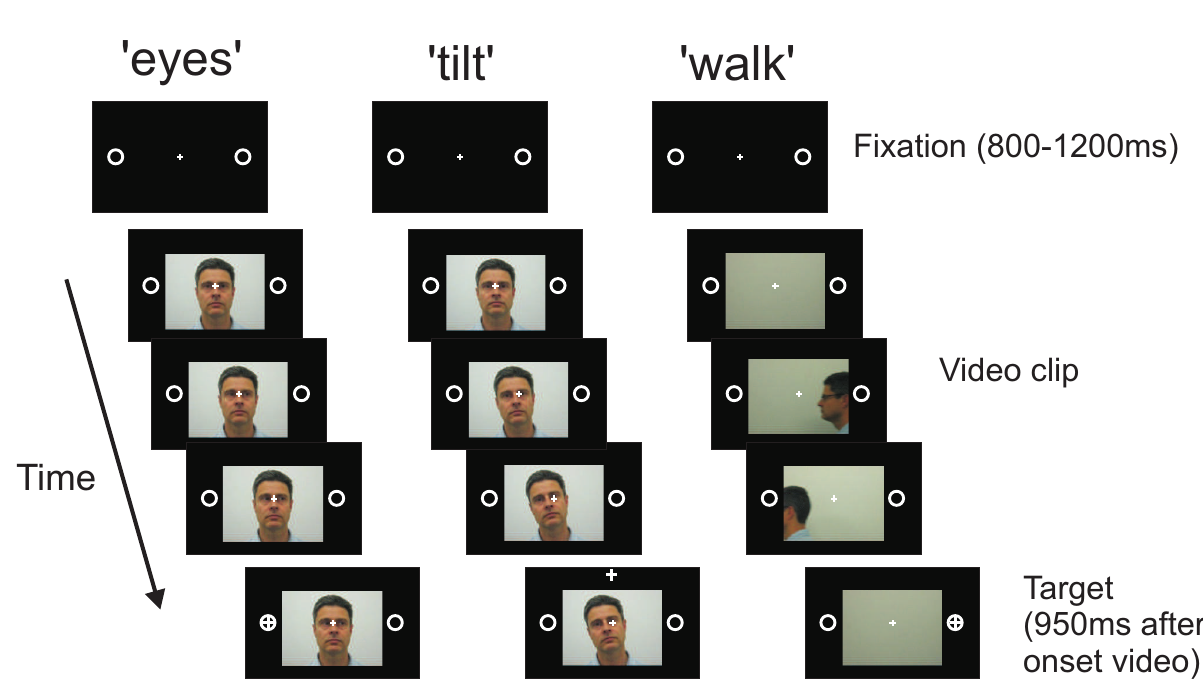
Figure 1 . Illustration of the three conditions in the experiment. In the ‘eyes’ condition, a video clip of an ‘actor’ making an eye movement to the left or to the right was shown. The ‘tilt’ condition presented a video clip showing the actor making a leftward or rightward head tilting movement. In the ‘walk’ condition, the actor was shown walking from the left to the right or vice versa. For each condition, the saccade target (a small plus sign) was presented 950ms after the onset of the video clip either to the left, to the right or above fixation (examples shown in the bottom row). The movement in the video clip started 500ms after its onset. The stimulus onset asynchrony of 950ms was chosen such that the movements in all of the cues was completed before the onset of the